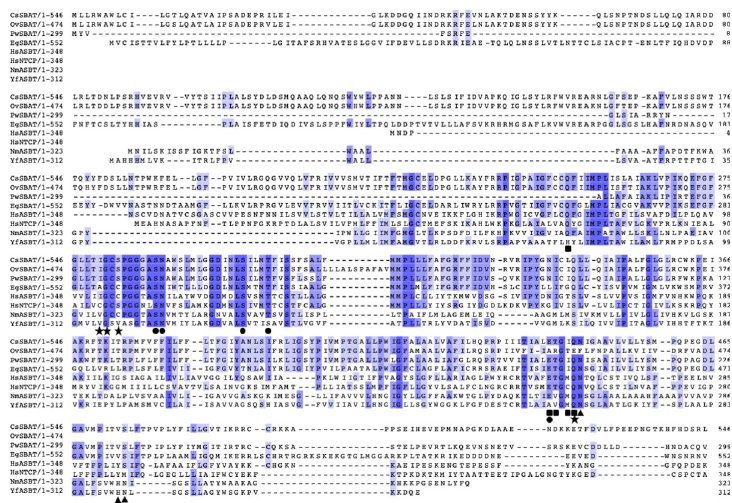
Fig 1. Multiple polypeptide alignment of CsSBAT and bile acid transporters from other species. Sequences were aligned and calculated using MAFFT v7.299 [35] with manual adjustment in Jalview [36]. Residues over 50% conserved among the transporters are shaded in light blue and 100% conserved residues are highlighted in dark blue. Residues that interact with sodium ions are labeled: Na1 site ( ● ), Na2 site ( ■ ), and putative Na3 site ( $ ). Residues necessary to coordinate with taurocholate in CsSBAT are also indicated ( ▲ ). Bile acid transporters are Opisthorchis viverrini SBAT (OvSBAT; A0A074Z5N1), Paragonimus westermani SBAT (PwSBAT; A0A5J4NIG5), Echinococcus granulosus SBAT (EgSBAT; W6UF08), human ASBT (HsASBT; Q12908), human NTCP (HsNTCP; Q14973), Neisseria meningitidis ASBT (NmASBT; Q9K0A9), and Yersinia frederiksenii ASBT (YfASBT; C4ST46).